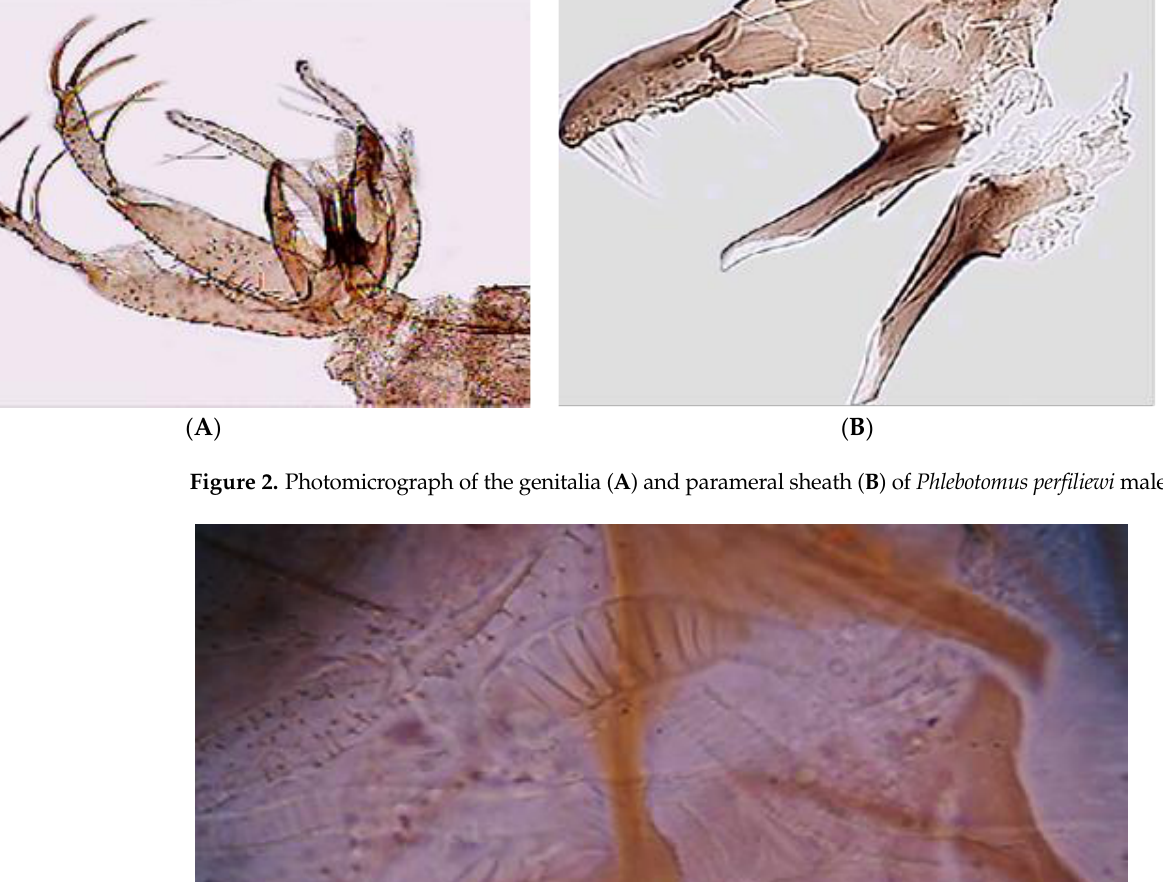
Figure 3. Photomicrograph of the female Ph. perfiliewi spermathecal duct (arrow indicates the large triangular wrinkled pocket).